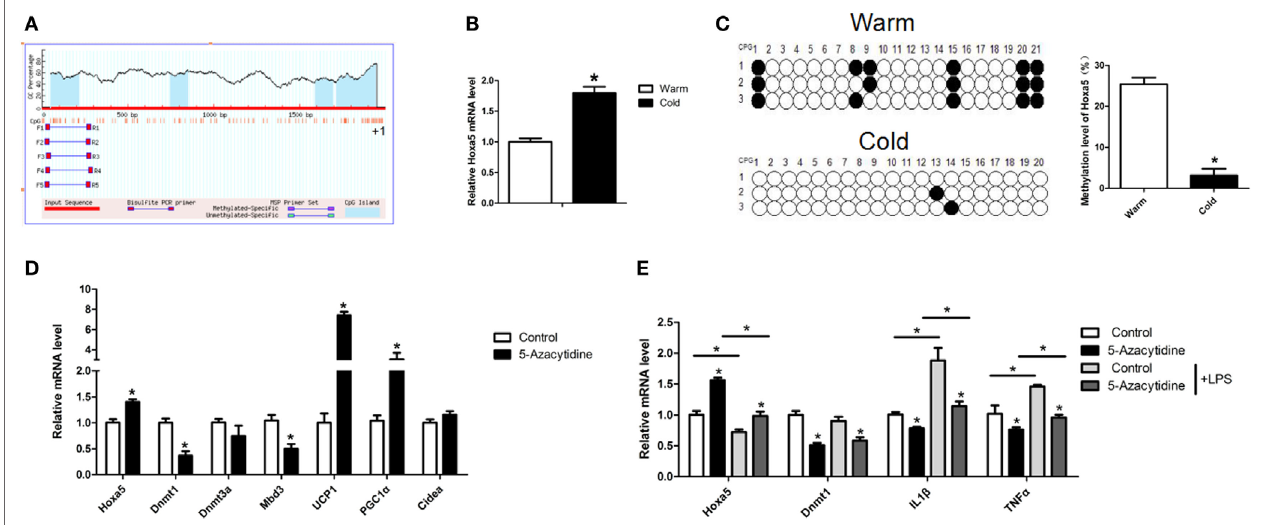
FigUre 5 | Methylation level of homeobox a5 (Hoxa5) is decreased along with increasing browning in adipose of cold exposed mice. (a) The schematic diagram of CpGs Hoxa5 promoter. (B) Relative mRNA level of Hoxa5 in inguinal white adipose tissue (iWAT) after 8 h cold exposure at 4°C ( n = 6). (c) The methylation level of CpG in − 148 bp ~ − 14 bp of the Hoxa5 promoter in iWAT of mice with or without 8 h cold exposure at 4°C ( n = 10). (D) Relative mRNA level of Hoxa5, Dnmt1, Dnmt3a, Mbd3, UCP1, PGC1 α , and Cidea in iWAT with 5-AZA injection ( n = 8). (e) Relative mRNA level of Hoxa5, Dnmt1, IL1 β , and TNF α in adipocytes with or without 5-AZA under lipopolysaccharide (LPS) treatment ( n = 4). Values are represented as means ± SD vs. control group, * p < 0.05.